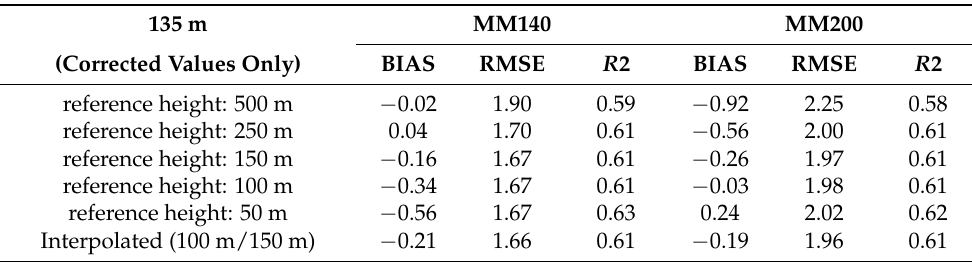
Table 4. Statistical analysis of downscaling based on reference height (exemplary stratified BILIN setup).